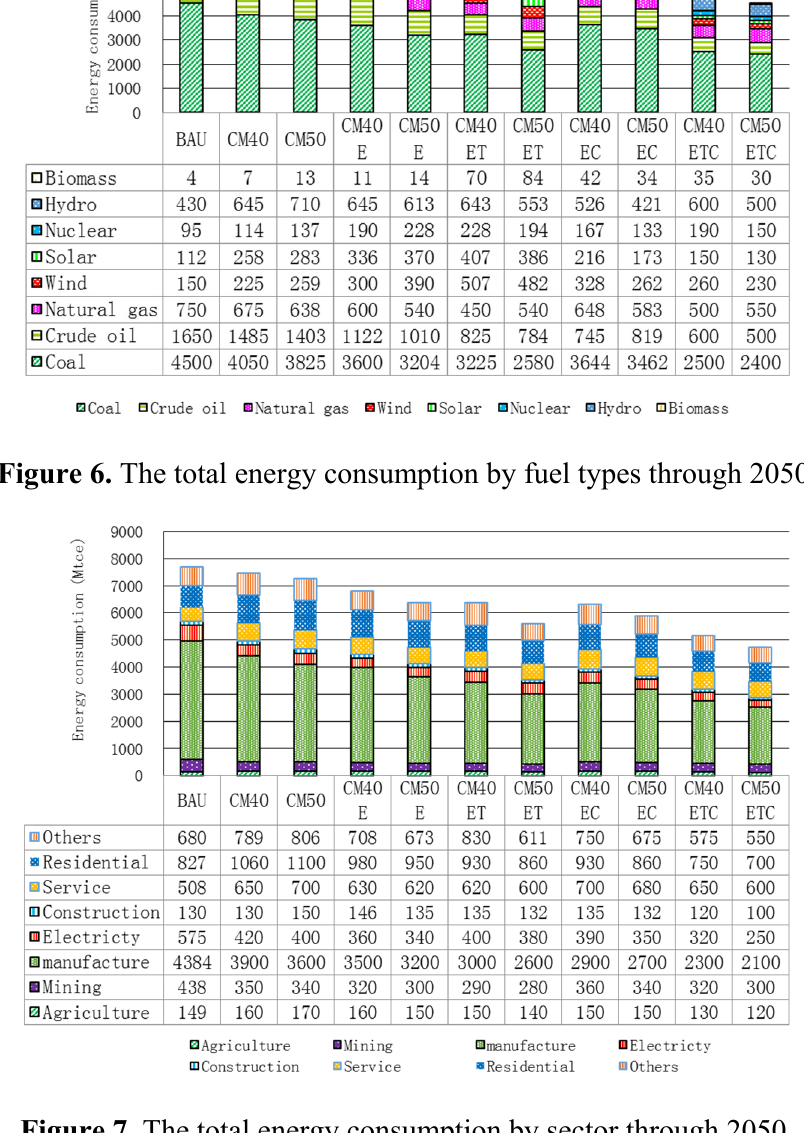
Figure 7. The total energy consumption by sector through